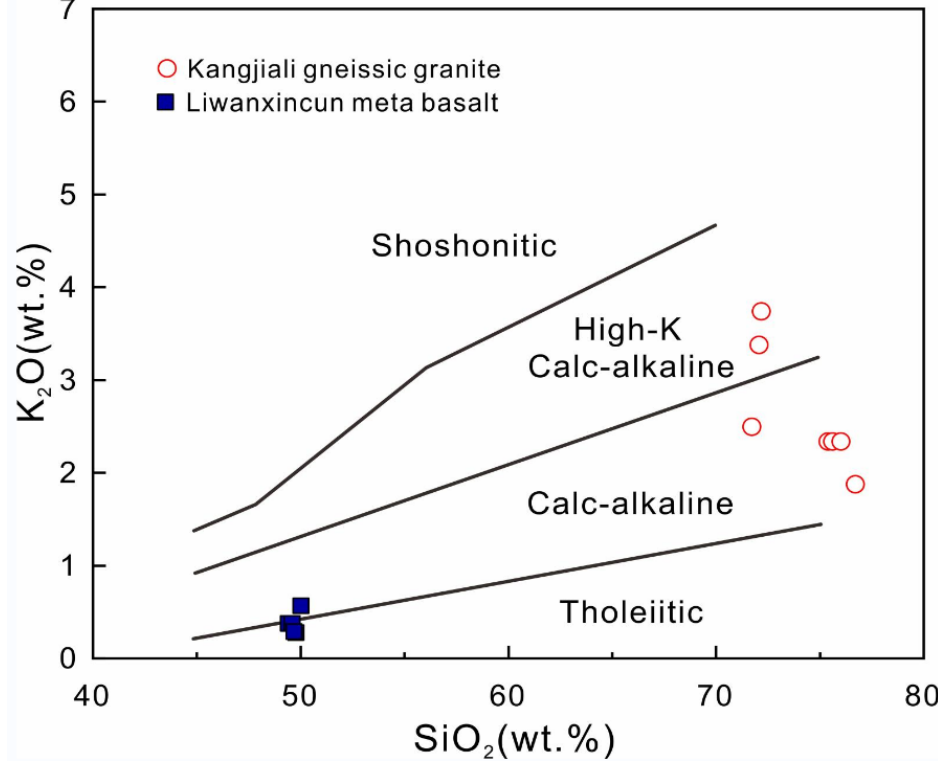
Figure 6. SiO 2 versus K 2 O diagram [25] of the Kangjiali gneissic granite and Liwanxincun metabasalt.